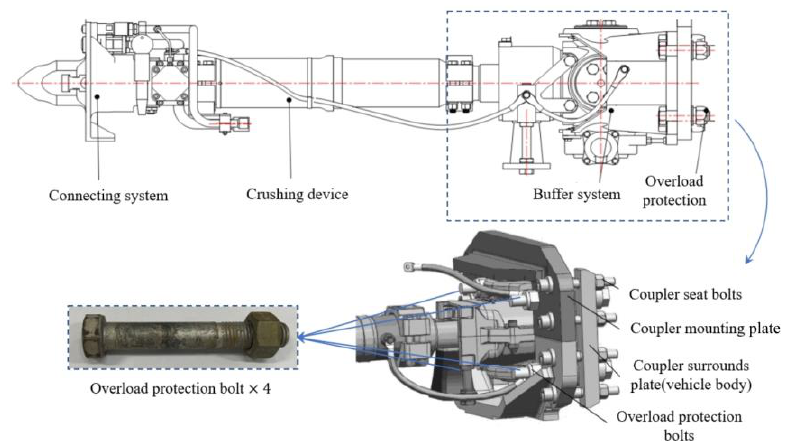
Figure 1. Overload protection bolts of the high-speed train couplings.